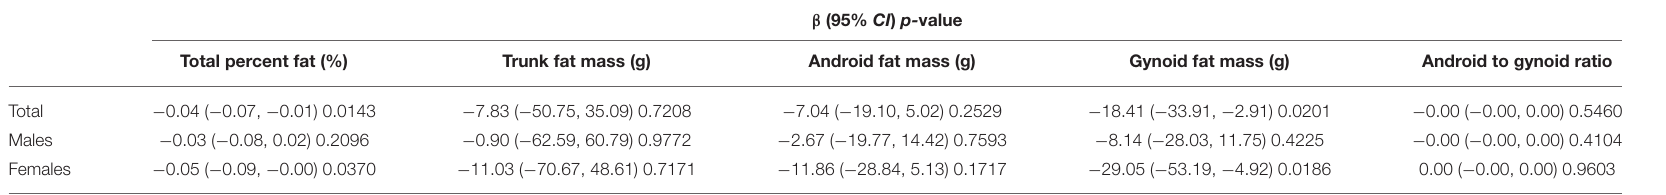
TABLE 5 | Associations of disease duration (years) with adiposity in patients with